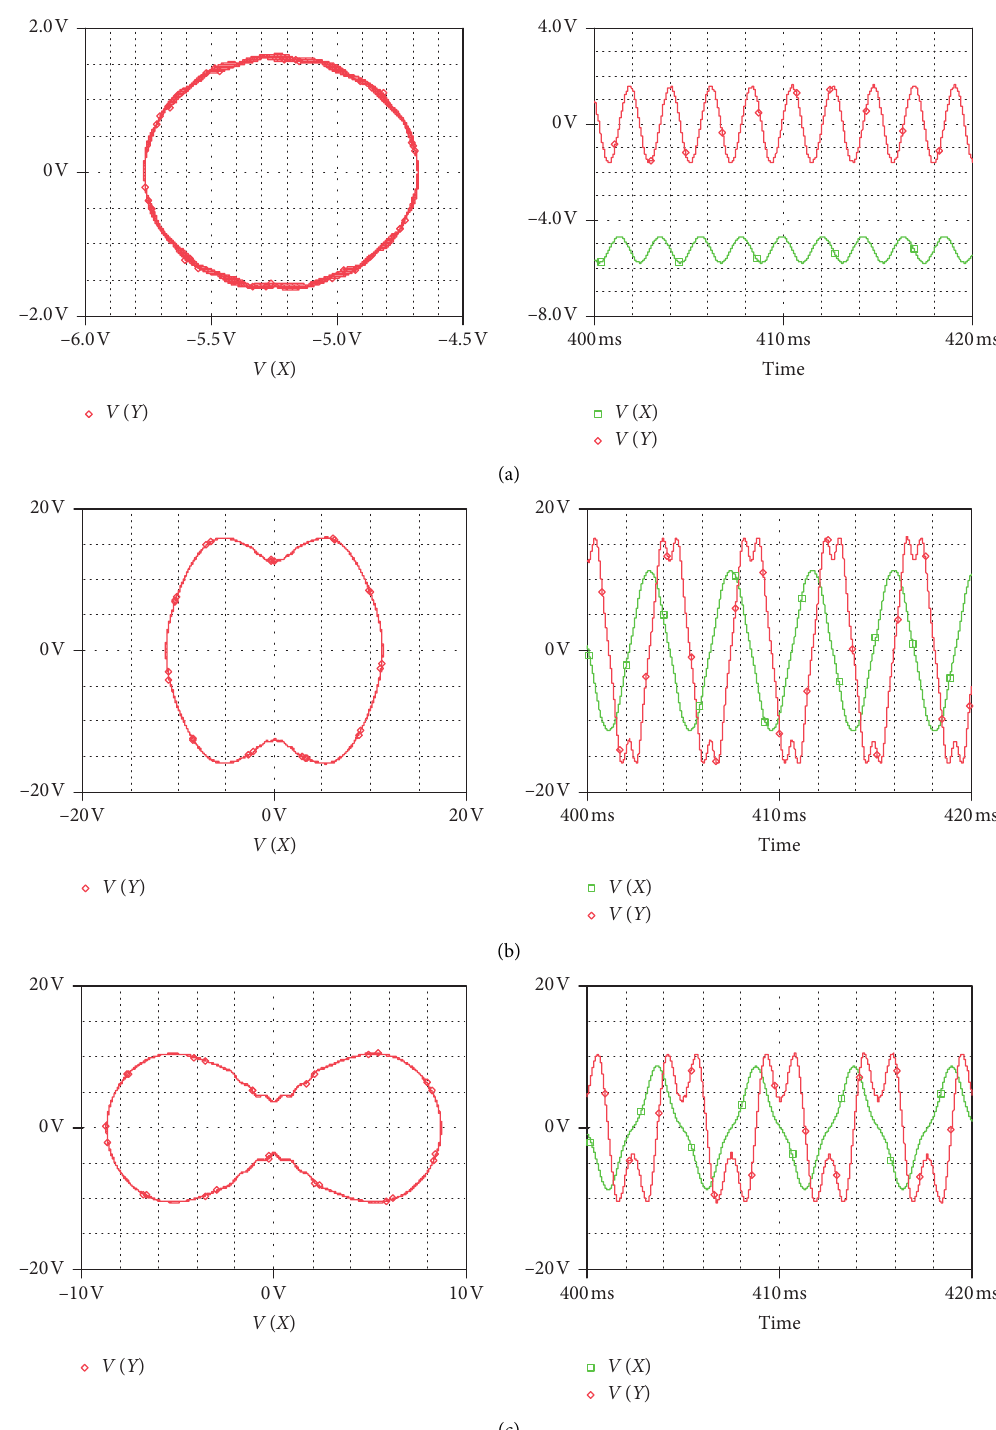
Figure 9: Some coexisting attractors obtained from the new megastable oscillator for R ( 10V , 1V ) , and ( 8V , 1V ) ,